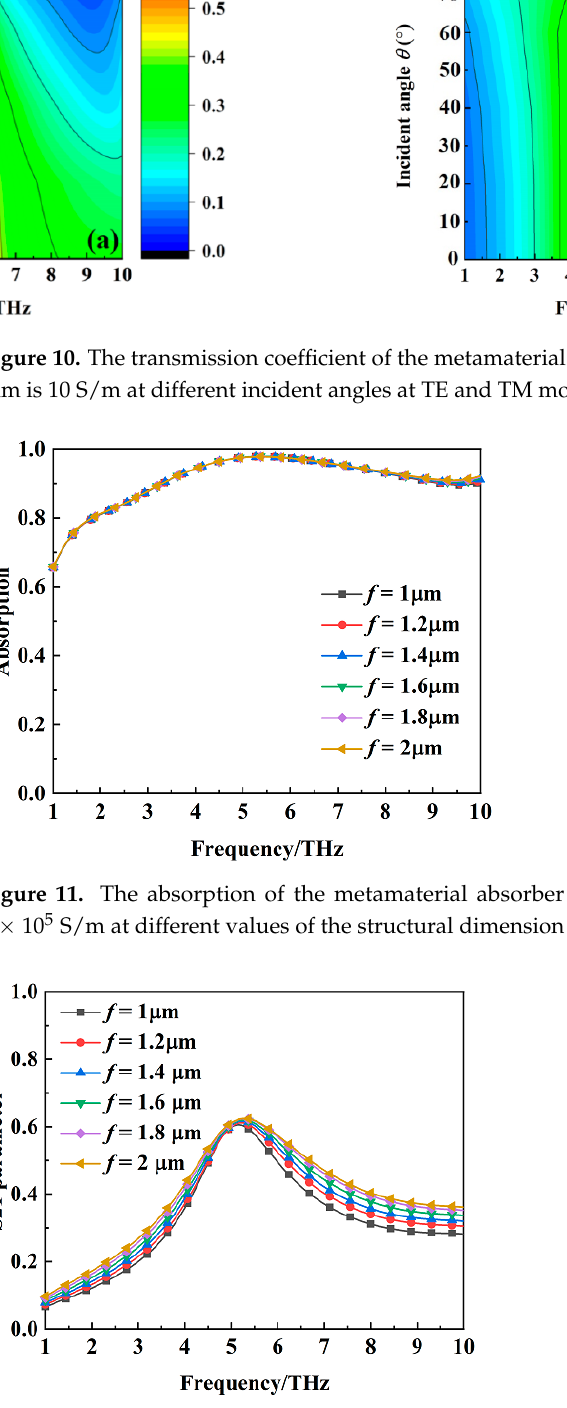
Figure 12. The transmission coefficient of the metamaterial absorber when the conductivity of VO 2 film is 10 S/m at different values of the structural dimension parameter f .